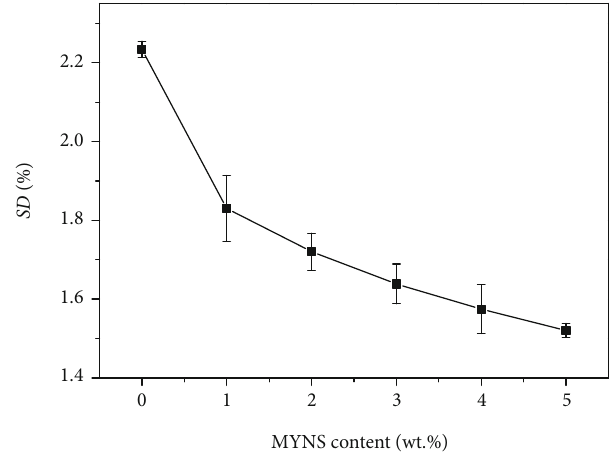
Figure 8: Swelling degree of PEG and PEG/MYNS membranes with di ff erent MYNS contents in